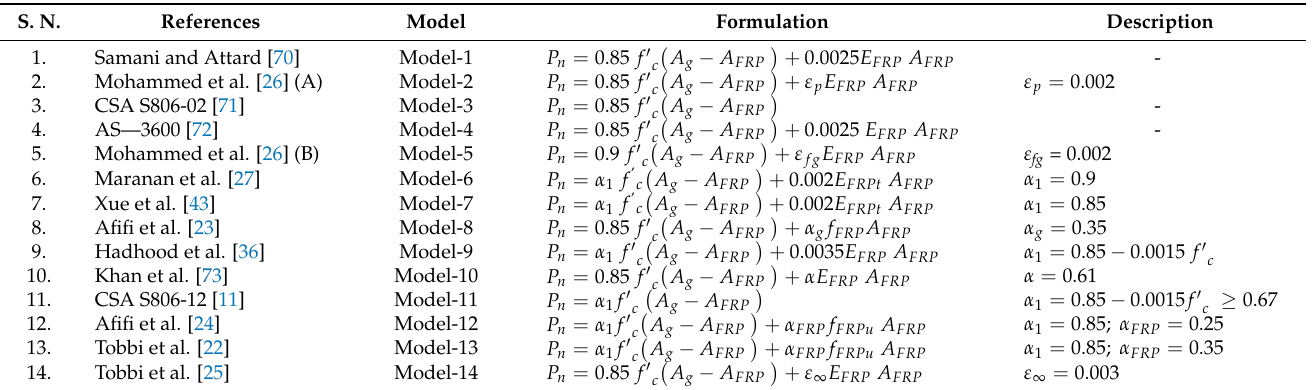
Table 3. Details of analytical